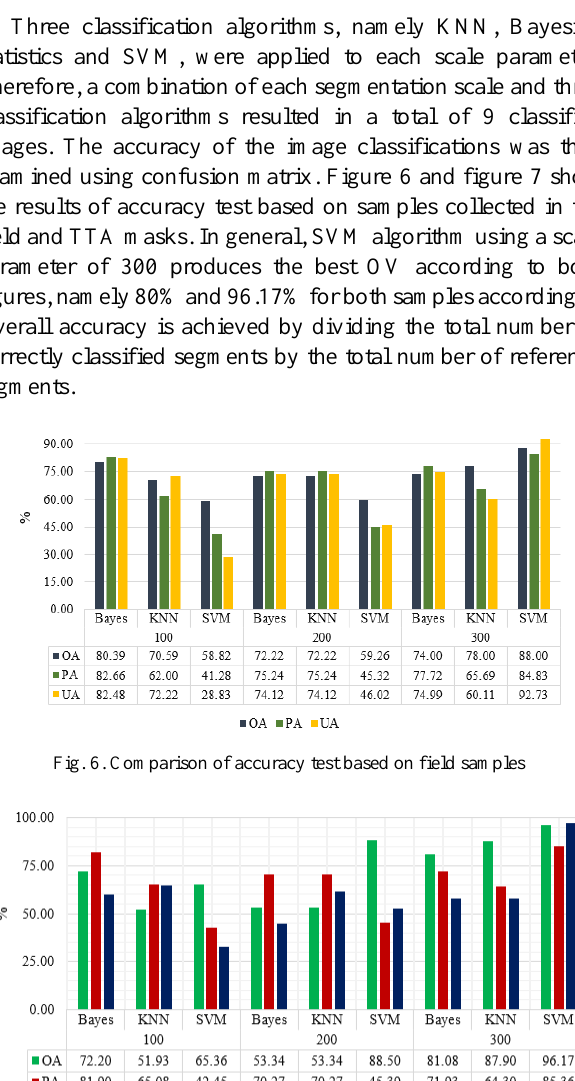
Fig. 9. Classification using SVM algorithm with a scale parameter of 200